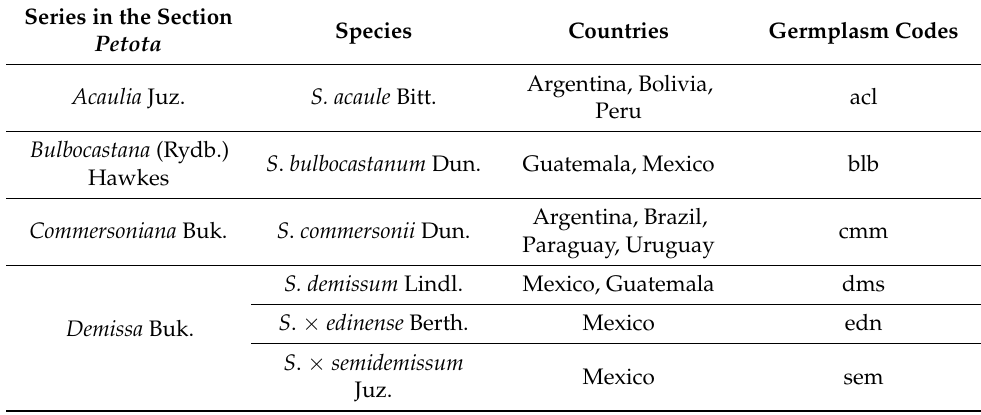
Table 1. Wild Solanum species section Petota Dumort. listed in the pedigrees of interspecific hybrids explored in this study. Species are listed as treated by Bukasov, Hawkes and Spooner [26,32,33]. Series in the Section Species Countries Germplasm Codes Petota Acaulia Juz. S. acaule Bitt. acl Bulbocastana (Rydb.) S . bulbocastanum Dun. Hawkes Commersoniana Buk.